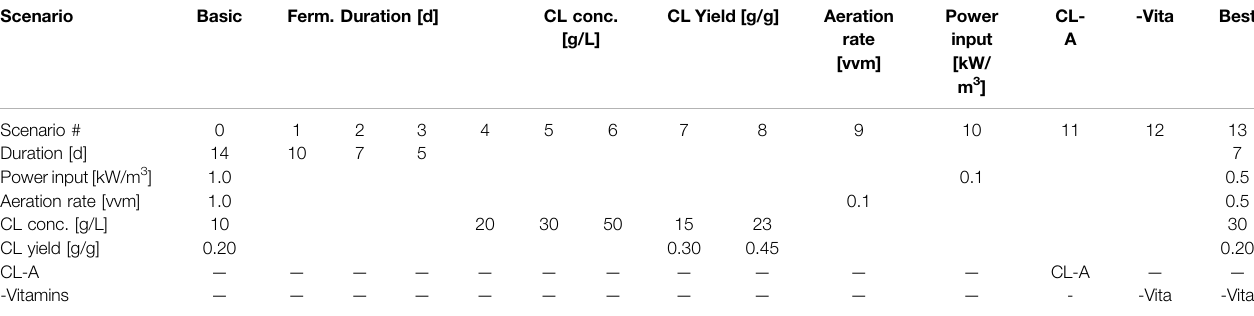
TABLE 2 | Overview of all varied parameters in the simulated scenarios used to estimate theoretical optimisation potentials.